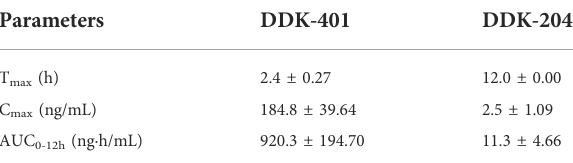
TABLE 3 Pharmacokinetic parameters of CK in human blood after oral intake of fermented ginseng extract (DDK-401) and red ginseng extract